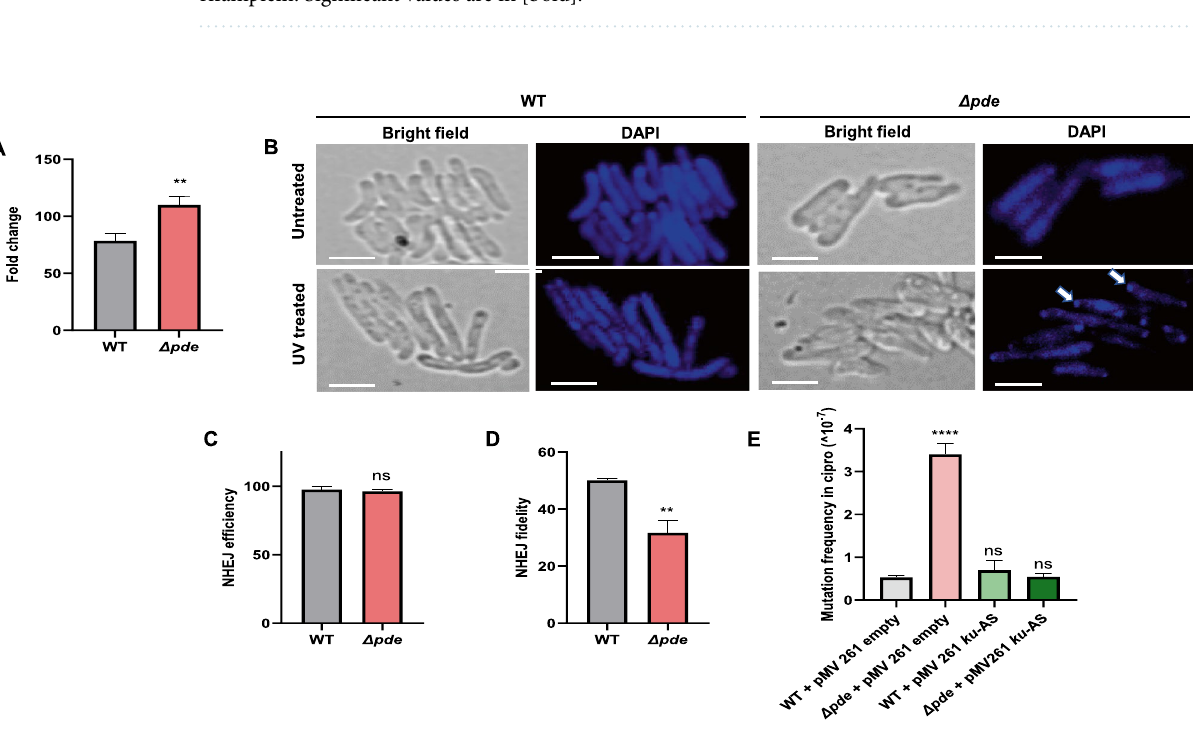
Figure 2. ( A ) A bigger fold change in rifampicin mutation rate was observed for M. smegmatis Δpde strain compared to M. smegmatis WT strain after UV induced mutagenesis [N = 3]. ( B ) Representative microscopic images were shown to compare cell damage, cell filamentation and chromosome disintegration in both M. smegmatis WT and M. smegmatis Δpde strain after a sublethal dose of UV exposure (0.125 mJ/cm 2 ). A lack of cellular filamentation in Δpde strain was indicative of the absence of RecA-mediated SOS repair in Δpde strain; white arrows indicate severe DNA condensation and damage. Microscopy scale bars = 2 µm. A plasmid-based assay was performed to estimate the NHEJ-driven repair phenomenon. Though ( C ) NHEJ efficiency was comparable between M. smegmatis WT and Δpde strain [N = 3], a significant drop in ( D ) NHEJ repair fidelity (~ 19%) was observed due to error-prone lacZ reannealing [N = 3]. ( E ) Knockdown of the principal NHEJ component Ku [by antisense (AS) approach] reversed the hypermutation phenotype in M. smegmatis Δpde strain, estimated by resistance frequency calculation against ciprofloxacin [N = 3]. All the graphs are plotted using GraphPad Prism8 (N = 3), unpaired t-test was used to calculate statistical significance: ***P < 0.001; **P < 0.01; *P < 0.05; ns =